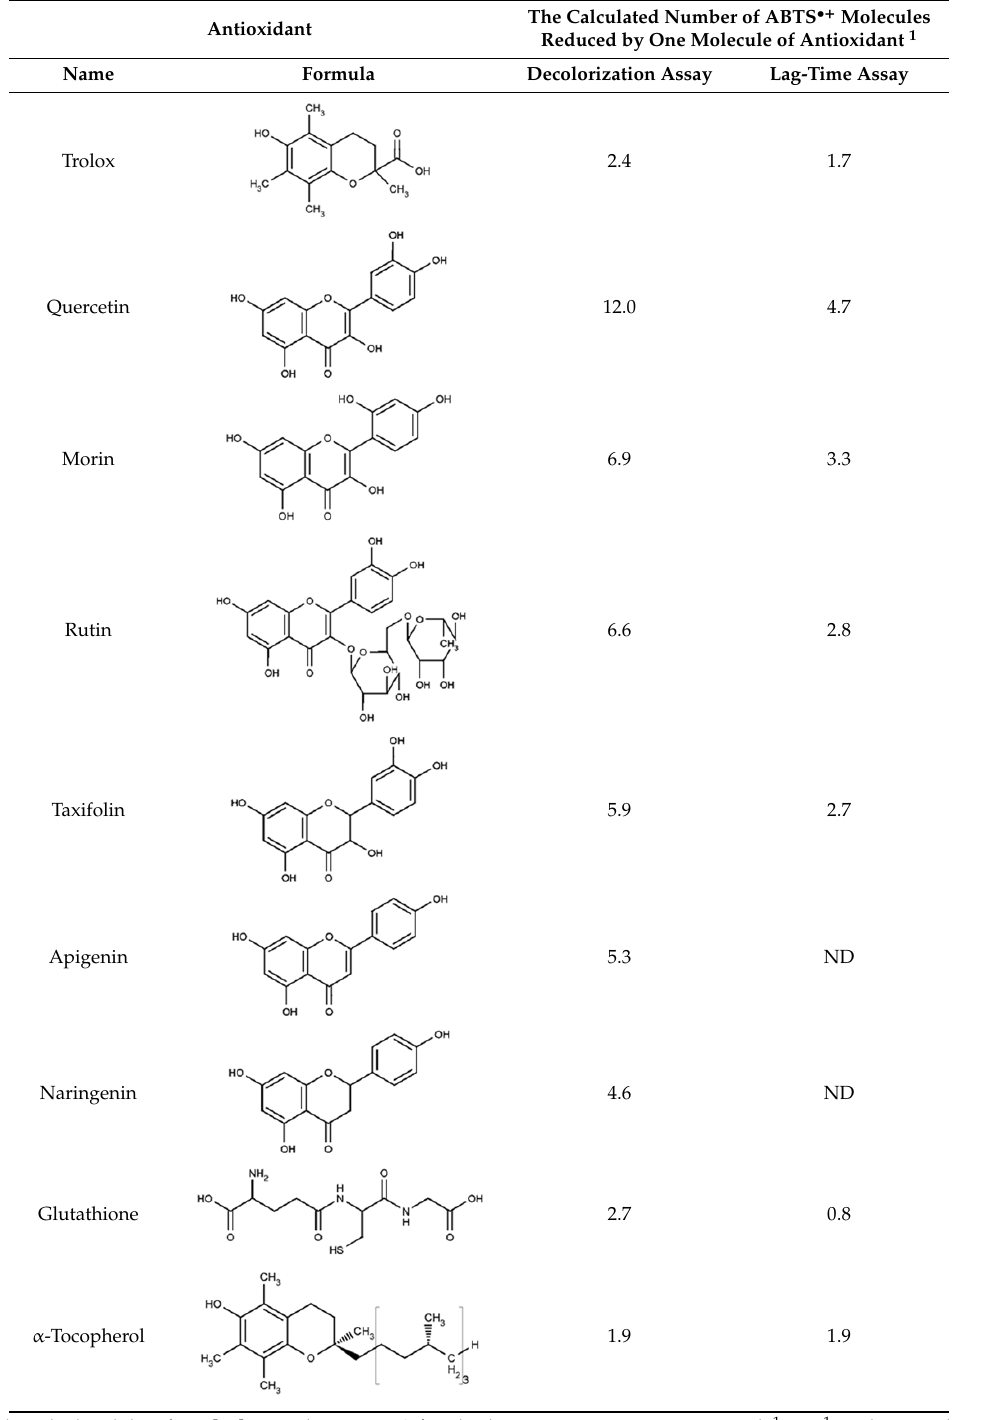
Table 4. Reagent concentrations in an ABTS/PP decolorization assay 1 . Antioxidant